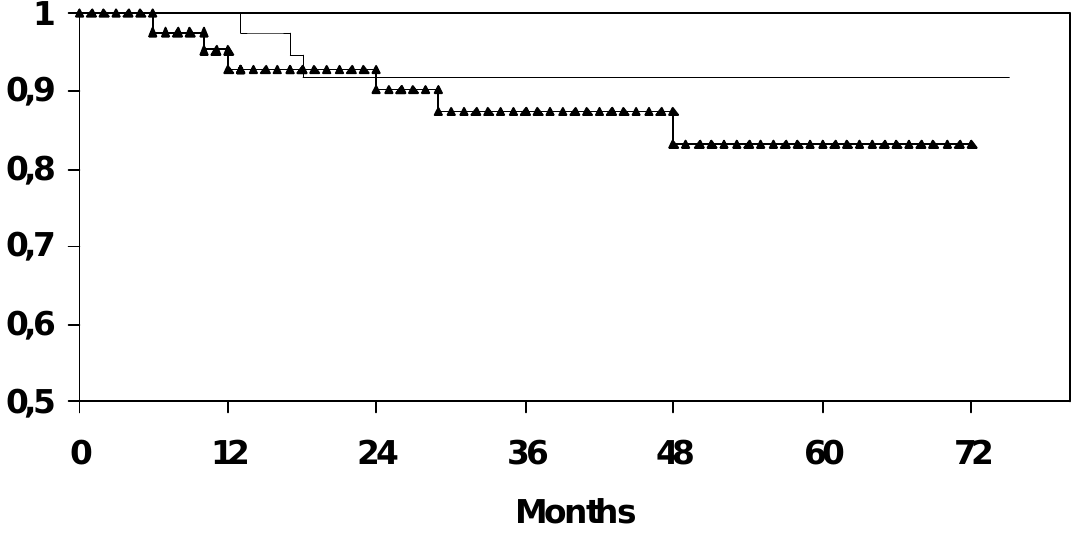
Figure 3. Univariate analysis (log-rank) for overall survival depending on supplementation of selenium (upper curve: with selenium; lower curve: without